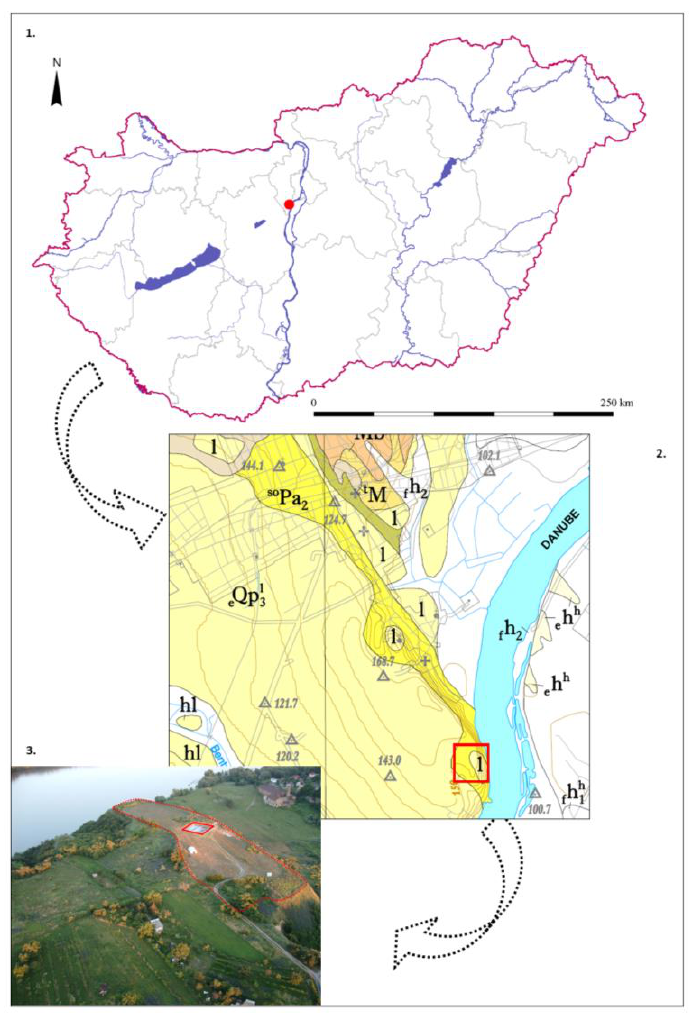
Figure 1. ( 1 ) Location of the Százhalombatta-Földvár Bronze Age fortified settlement within Hun- gary; ( 2 ) the geographic setting of the settlement marked with a red square. Notes: e Qp 3l —loess; so Pa 2 — Somlói Formation (gray aleurit with clayey marl with molluscs such as Congeria , Melanopsis , and Dreissena ); t M — Tinnyei Formation (yellow biogenic limestone with molluscs); ( 3 ) aerial view of the site with the boundary of the tell (dashed red line) and that of the excavation trench (red contin- uous line) (modified after [40]).